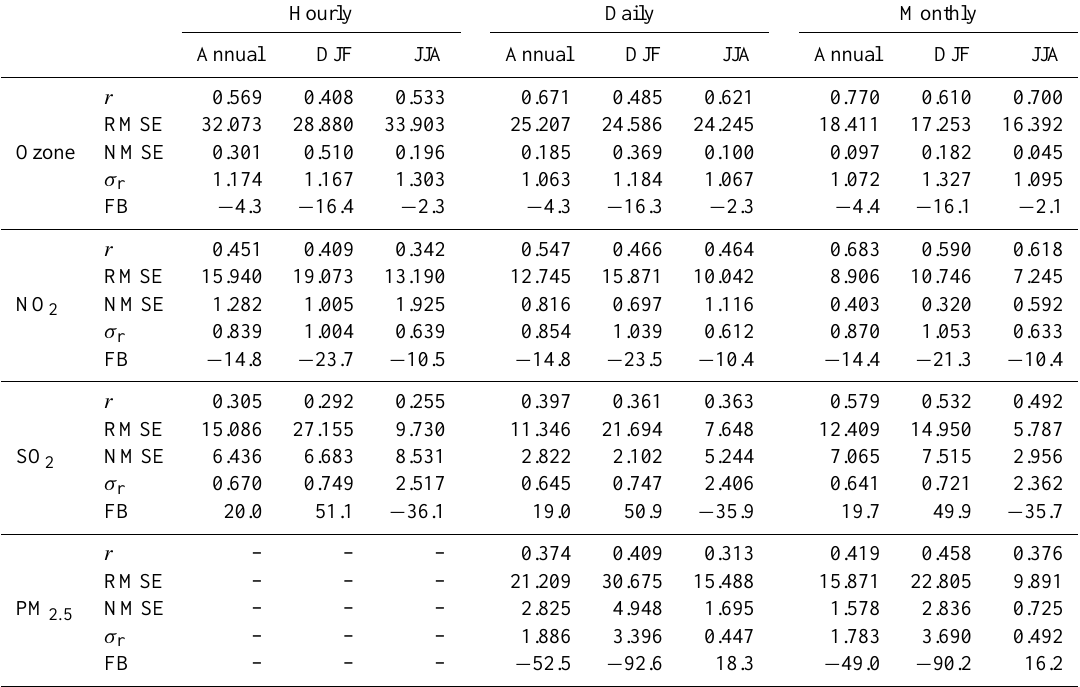
Table 2. Comparison of model data with measurements: evaluation of the correlation coefficient ( r ), root mean square error (RMSE; in µgm − 3 ), normalized mean square error (NMSE), the ratio of standard deviations ( σ r ) and fractional bias (FB; in %) for hourly, daily and monthly averages for winter (DJF) and summer (JJA) months and for the whole year (“annual”) for pollutants O 3 , NO 2 , SO 2 and PM 2 . 5 . For PM 2 . 5 , no hourly data were